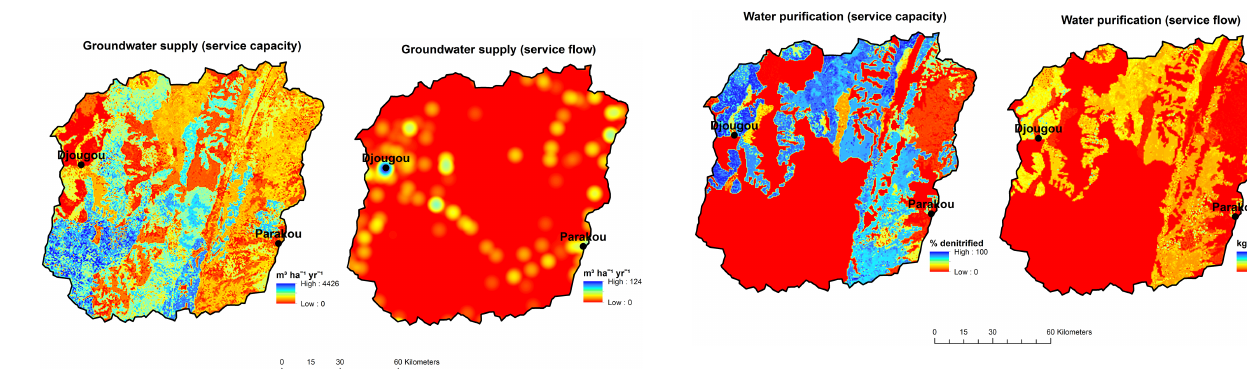
Figure 4. Spatial distribution of mean annual values of service ca- pacity and mean seasonal values of service flow of crop water sup- ply in upland agricultural areas in the Upper Ouémé watershed from 2001 to 2012 (GP indicates growing period).